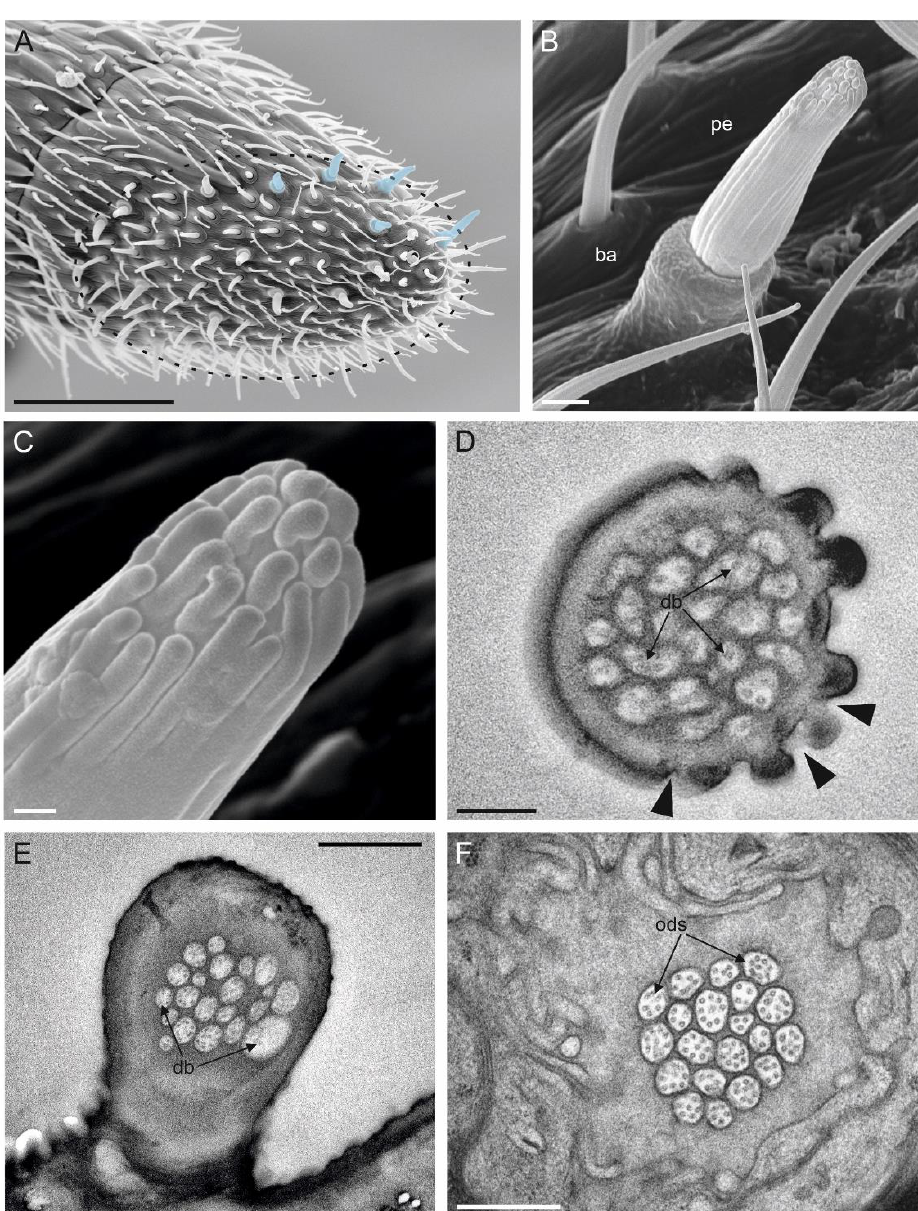
Figure 7. ( A ) Apical part of the female antennal F7 of Anagyrus vladimiri in a ventral view. The apical area appears like a flattened sole where several sensilla are inserted. In the blue mask, some of the multiporous basiconic sensilla (MBS) are highlighted. ( B ) Detail of MBS at SEM. The sensillum presents a cylindrical base (BA) that is inflexibly inserted on the antennal wall. A grooved peg (pe) is inserted on top of the cylindrical base. ( C ) Close-up view of the apical region of MBS. The grooves that are present on the cuticular shaft end in elongated finger-like projections. ( D ) TEM picture showing a cross-section of the apical part of MBS. On the right side, it is possible to observe the finger-like projections and the pores (black arrowheads) partly hidden by the same projections. The internal lumen is filled with dendritic branches (db). ( E ) TEM section at the basal region of MBS: the cuticular wall appears thicker and aporous, and the same number of db is visible. ( F ) TEM cross-section through the outer dendritic segments (ODS) of the sensory neurons innervating a single MBS. Scale bar: ( A ): 30 µ m; ( B , E ): 1 µ m; ( C , D ): 0.2 µ m; ( F ): 0.5 µ